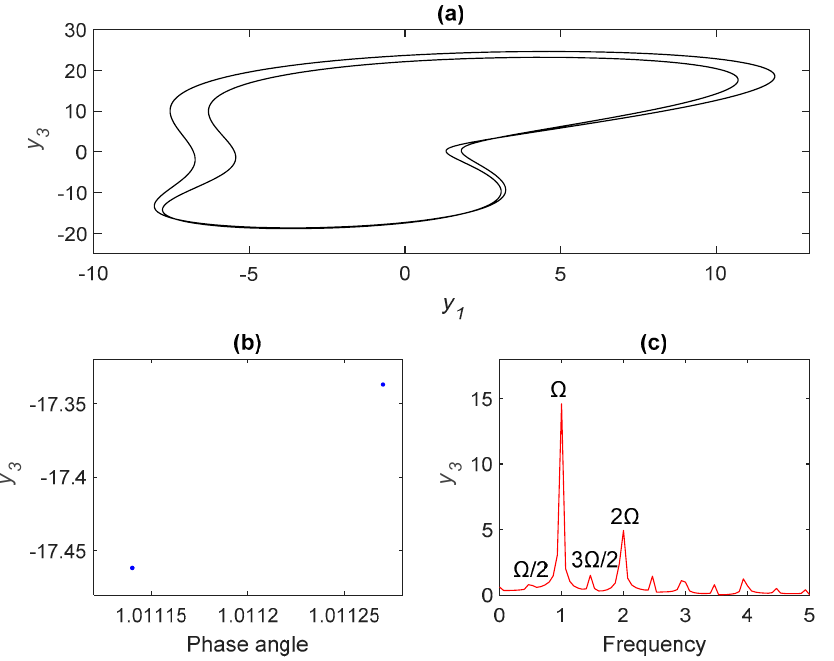
Figure 3. Period-2 motion for σ = 4.15: ( a ) phase portraits, ( b ) Poincare maps, and ( c ) frequency spectra.